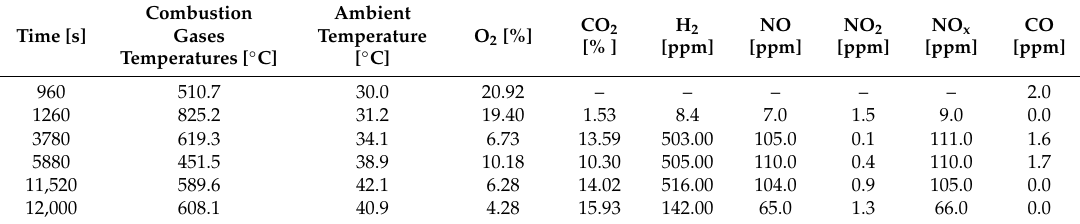
Table 2. Exhaust gases concentration and temperature vs.